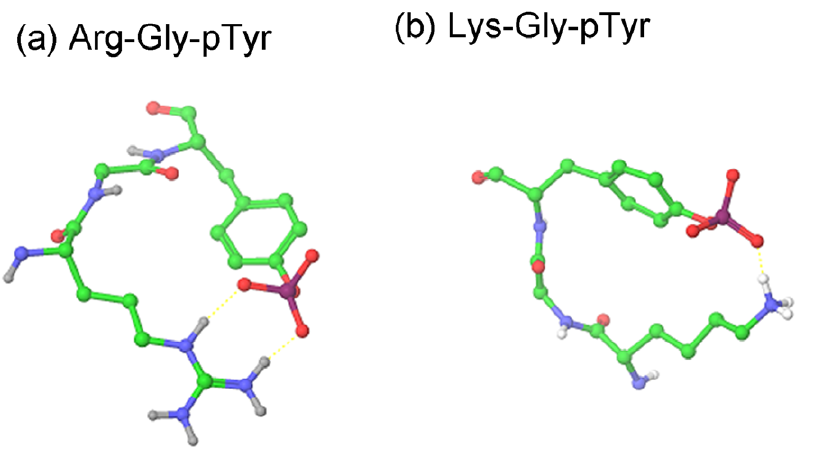
Figure 2. Snapshots from molecular dynamics simulation of two tripeptide systems. Interactions appearing at high frequency are (a) bidentate hydrogen bond in Arg-Gly-pTyr( 2 2) and (b) single hydrogen bond in Lys-Gly-pTyr( 2 2). Hydrogen Bonds are indicated by dotted yellow lines.